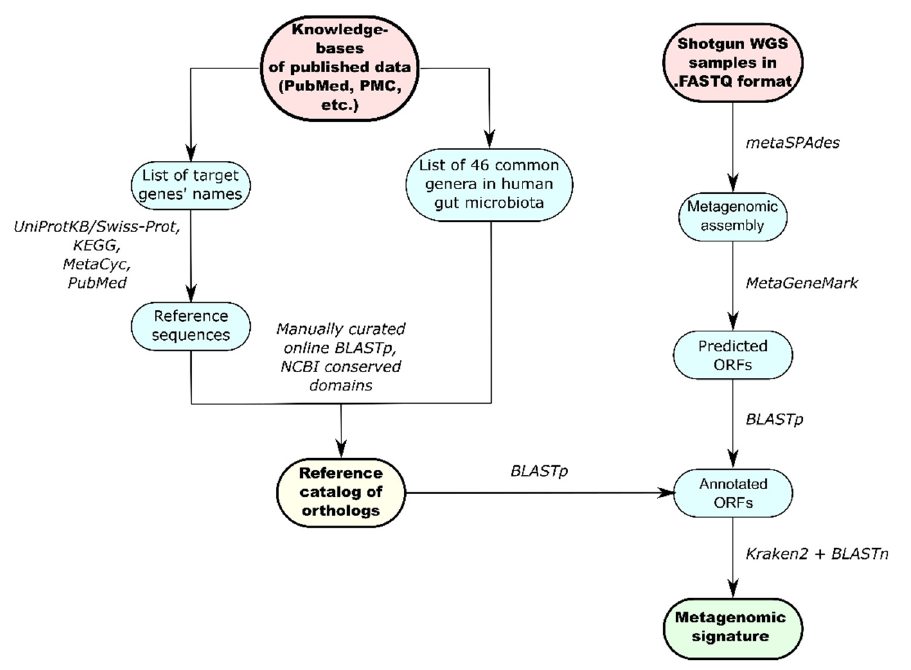
Figure 1. Schematic representation of the general bioinformatic workflow, including the algorithms for the reference catalog assembly and metagenomic signature reconstruction. for the reference catalog assembly and metagenomic signature